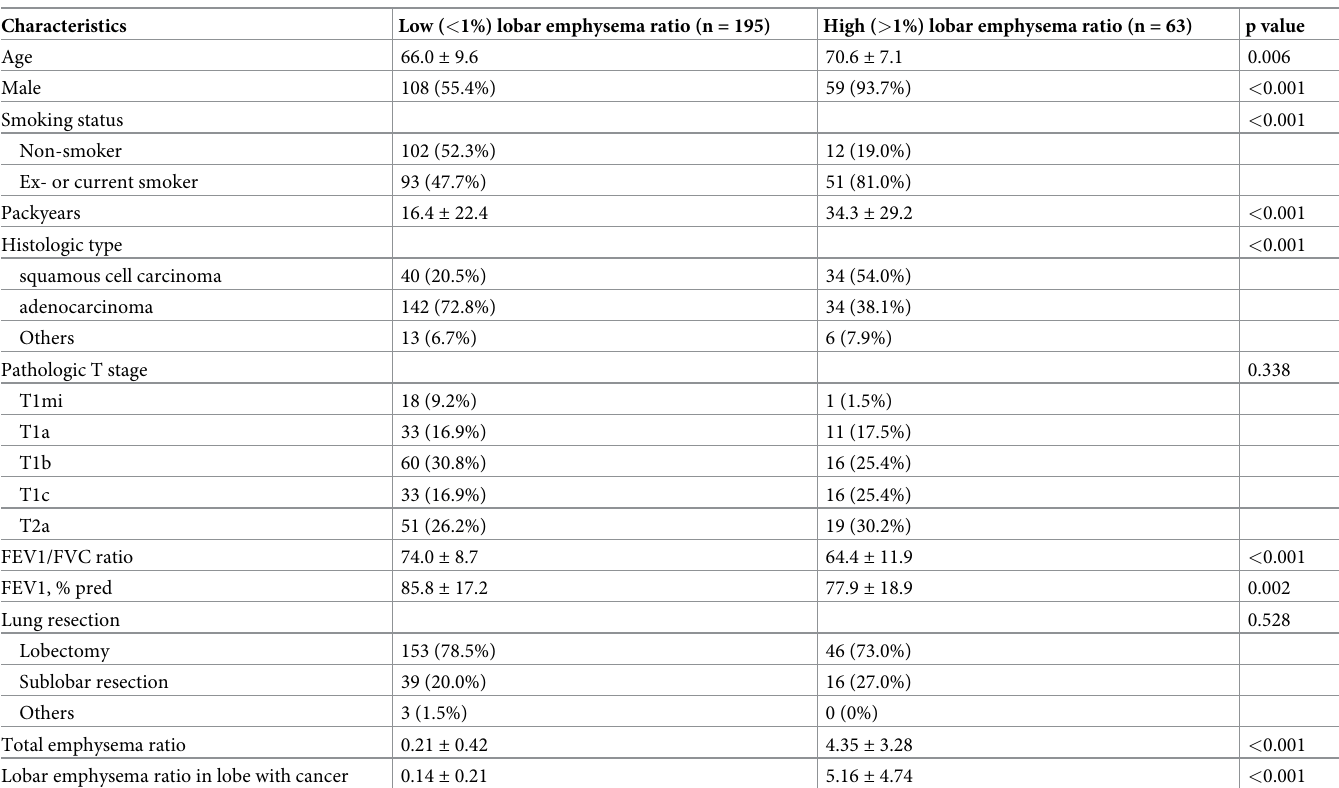
Table 1. Patient characteristics according to the lobar emphysema